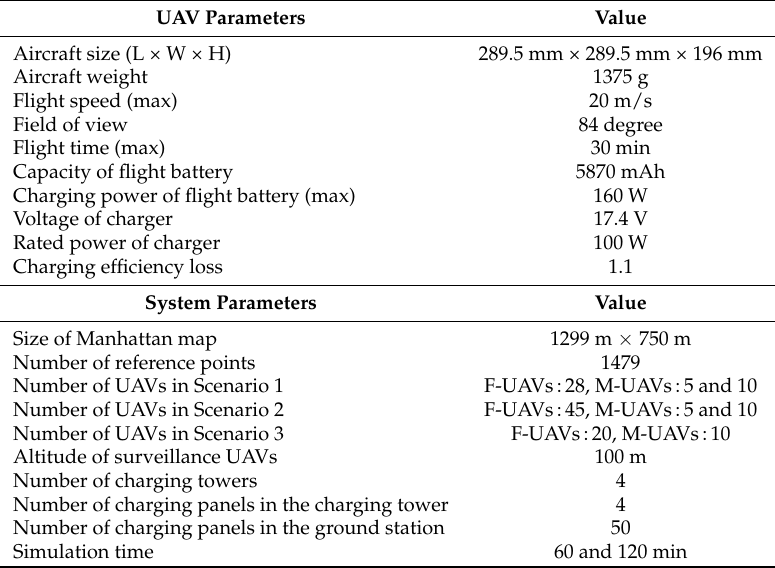
Table 3. Environmental setup